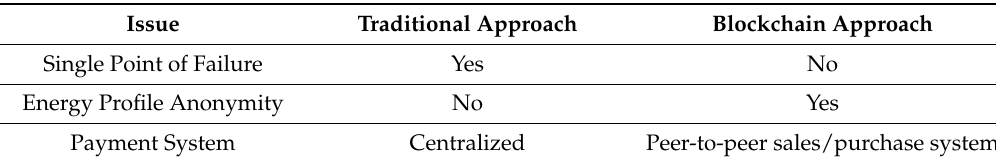
Table 1. Blockchain vs. traditional smart grid